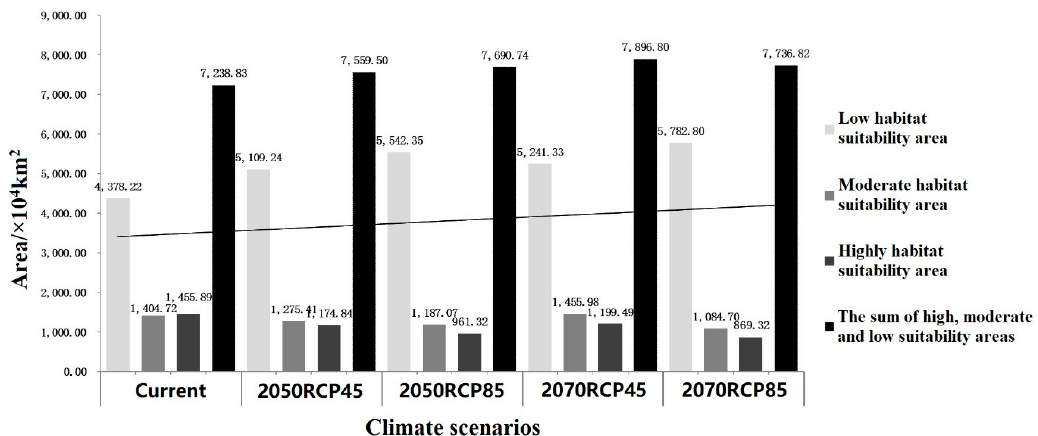
Figure 8. MaxEnt models predicting suitability areas of Icerya purchasi on global scale under different climate scenarios.